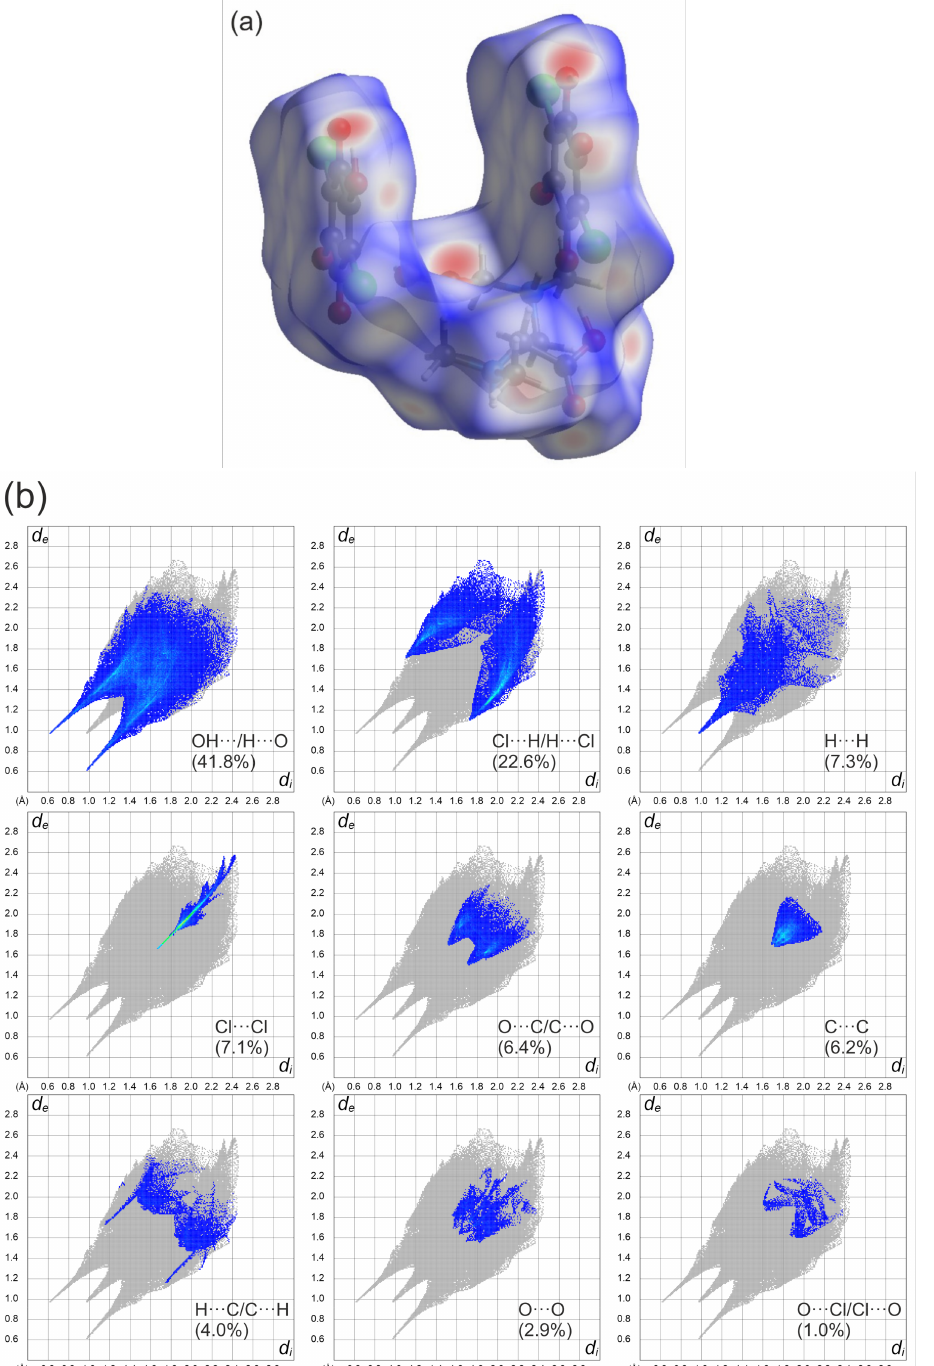
Figure 4. ( a ) Hirshfeld surface analysis for the N,N-dimethylglycine–chloranilic acid co-crystal. Parameters mapped onto the surface d norm . ( b ) Fingerprint plots generated with relative percentage contributions of particular intermolecular contacts to the Hirshfeld surface